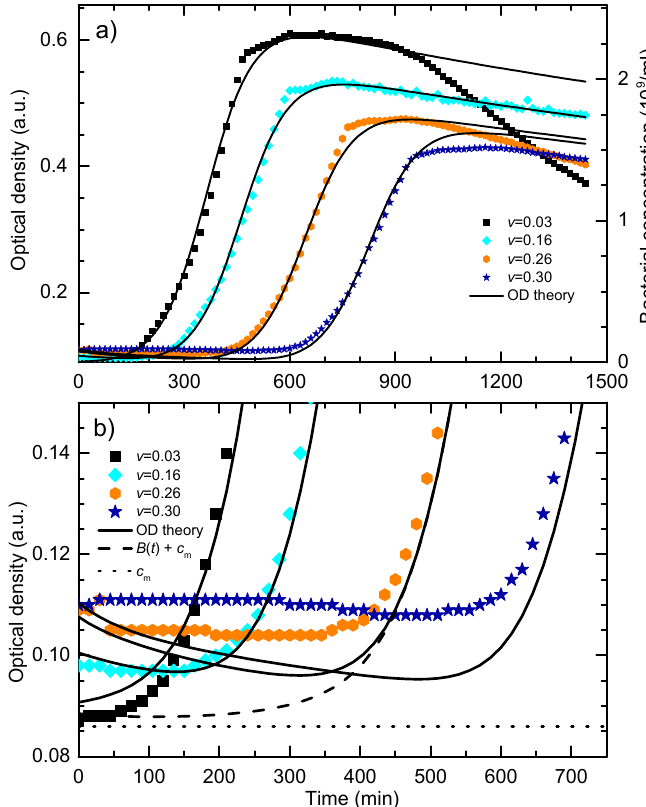
Figure 7. ( a ) Comparison of the experimental curves (symbols) with theoretical fits for di ff erent v values (lines). ( b ) the first 700 min of the OD signal from Figure 7a. The symbols are the raw experimental data for the di ff erent colloid volume shares and the full lines are the theoretical fits as given by Equations (1)–(3) and Equation (12). The dashed line is the theoretical bacterial concentration B ( t ) for v = 0.26 summed with the constant c m = 0.086. The dotted line is c m = 0.086 a.u., i.e., the optical density of the well plate and the master